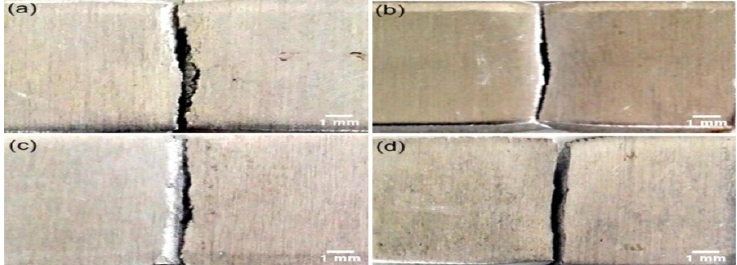
Figure 5. Rupture morphology of the Al-6061 specimens fractured under the conditions of 1.1 kW/cm 2 laser power density and various preloaded speeds of ( a ) 0.5 mm/min; ( b ) 1 mm/min; ( c ) 2 mm/min; ( d ) 4 mm/min.